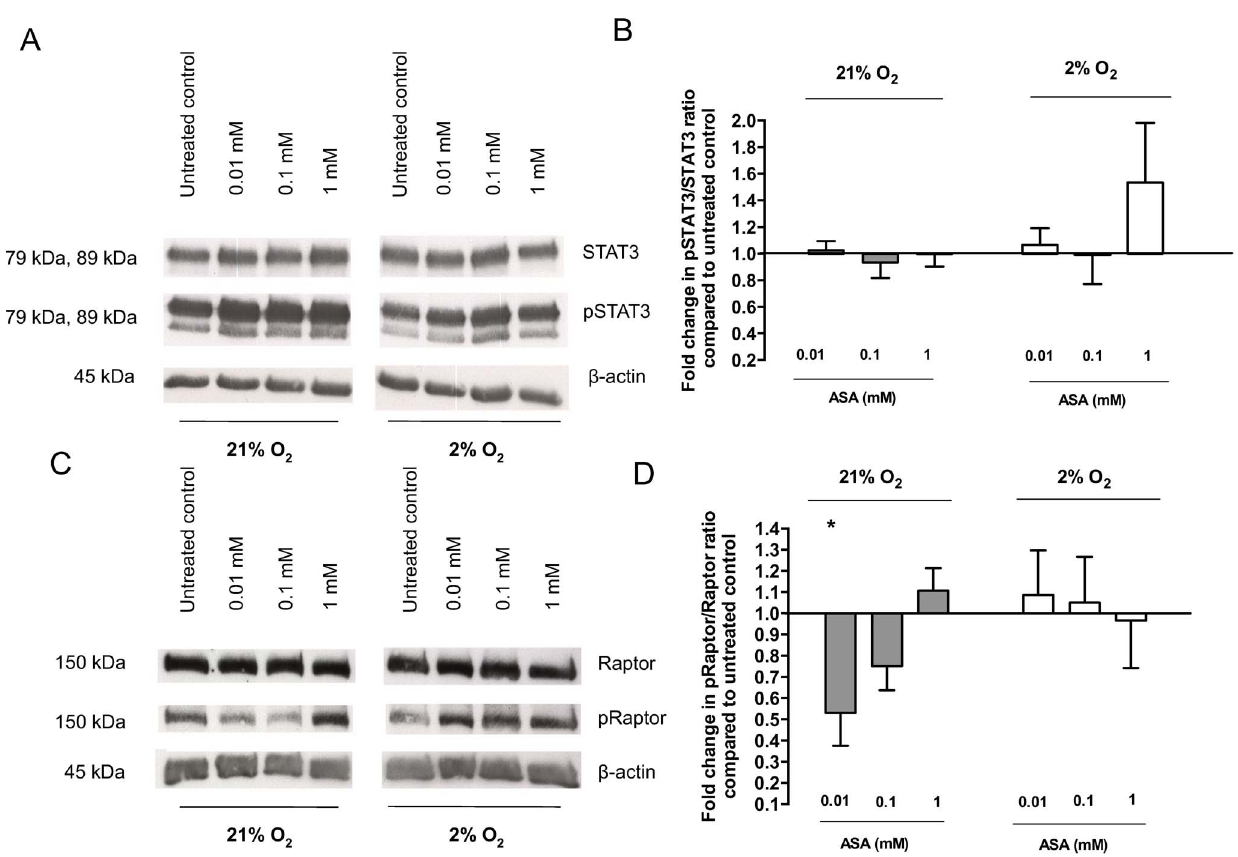
Figure 4. Protein expression of pSTAT3/STAT3 (A, B) and pRaptor/Raptor (C, D) after 2 h of incubation with ASA (0.01 mM, 0.1 mM, 1 mM) at different oxygen levels (21% and 2% O 2 ). Representative Western blot of STAT3, pSTAT3 and b -actin (A, C). Representative bars (B, D) show effects on pSTAT3/STAT3 and pRaptor/Raptor ratios compared to untreated control. Data are presented as relative means 6 SEM. *p , 0.05 compared to untreated control (set to 1).